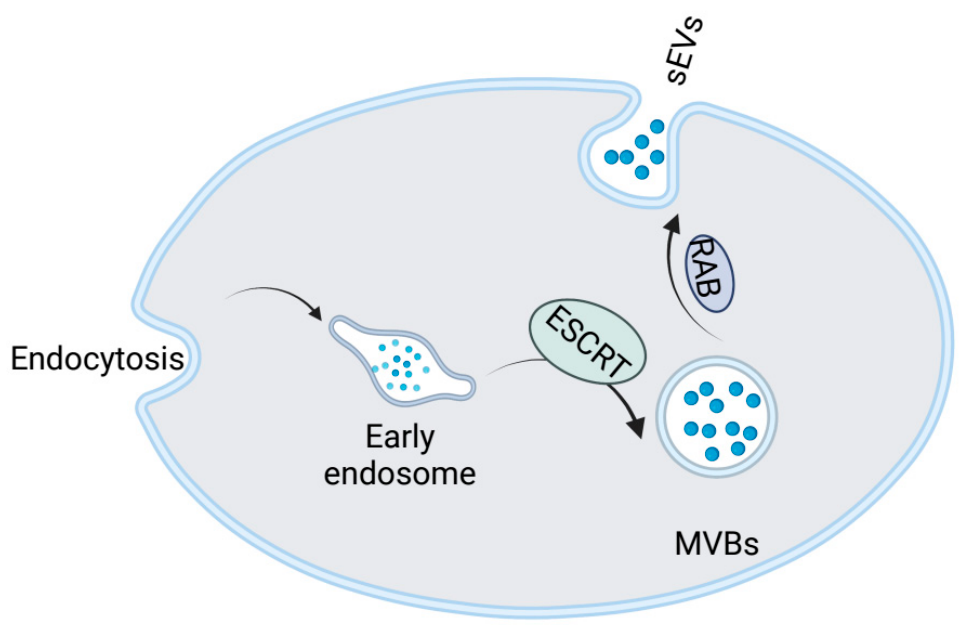
Figure 1. Mechanism of sEVs formation. This figure summarizes the formation process of sEVs. sEVs form MVBs via the endosomal pathway, which are then released into the extracellular space by binding MVBs to Rab 27a and 27b. (This figure was created with Biorender.com). Table 1. Separation methods for